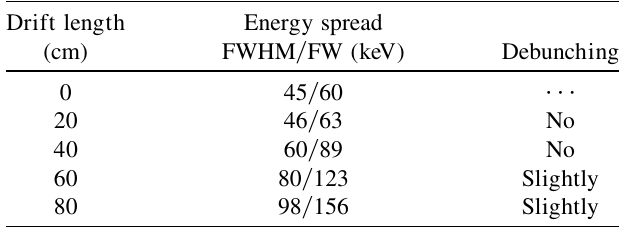
Longitudinal energy spread versus drift length